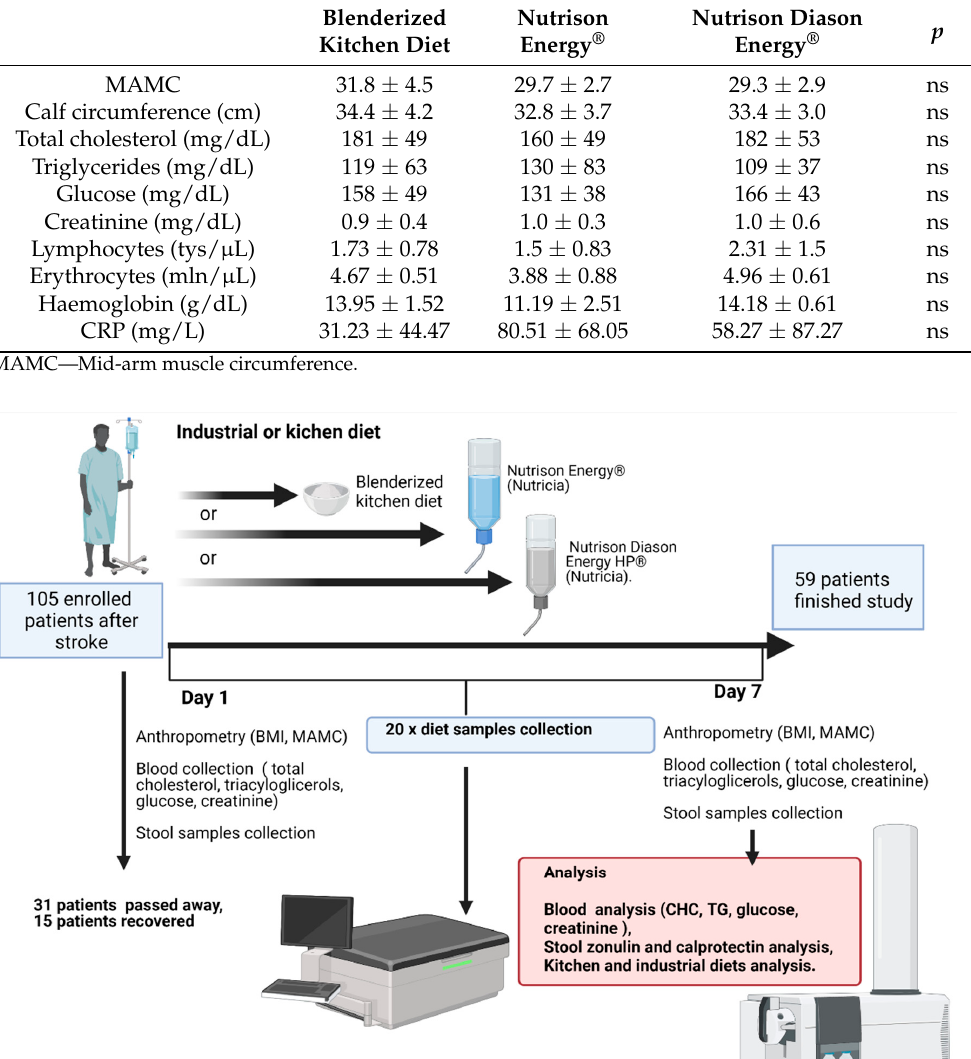
Table 1. Comparison of blood biochemical parameters and anthropometric measurements in patients on Day 1 of the study.